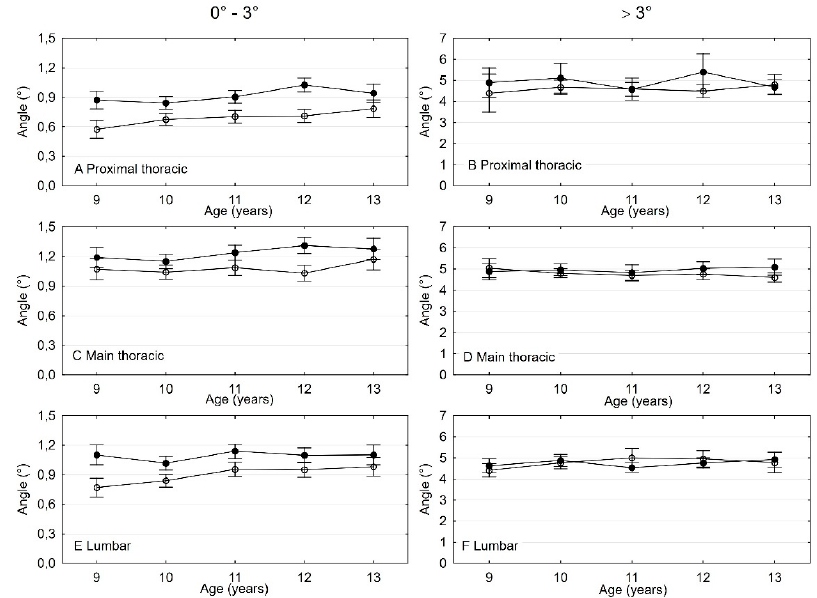
Figure 4. Two-factor analysis of variance to assess differences in ATR value.* * Lines on charts with full bullet points means girls and with empty bullet points boys.